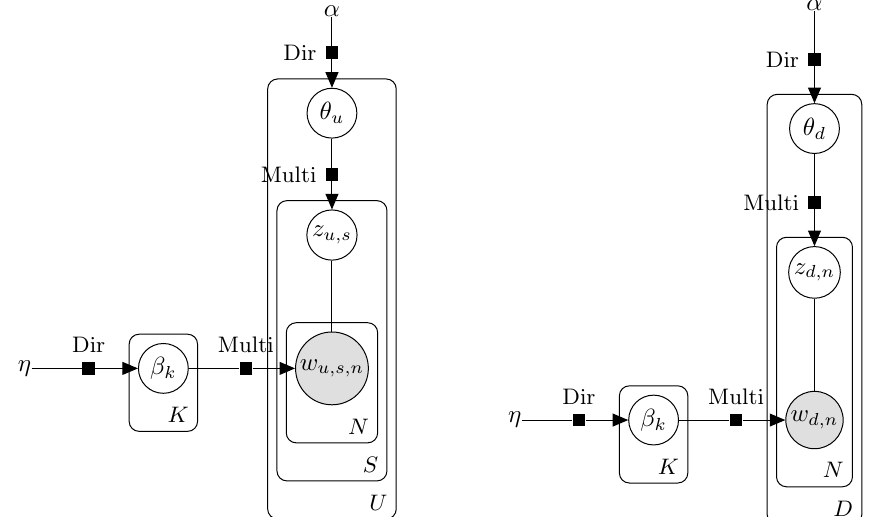
Figure A.1. Plate notation comparison for the Twitter Latent Dirichlet Alloca- tion (T-LDA) (left) and the standard Latent Dirichlet Allocation (LDA) (right) models. Here nodes are random variables; edges indicate dependence through probability distributions (e.g., Dirichlet or multinomial). Shaded nodes are observed; unshaded nodes are latent. Plates indicate replicated variables. Note that the T-LDA model aggregates tweets from each user into a document and constrains each tweet to be drawn from only one